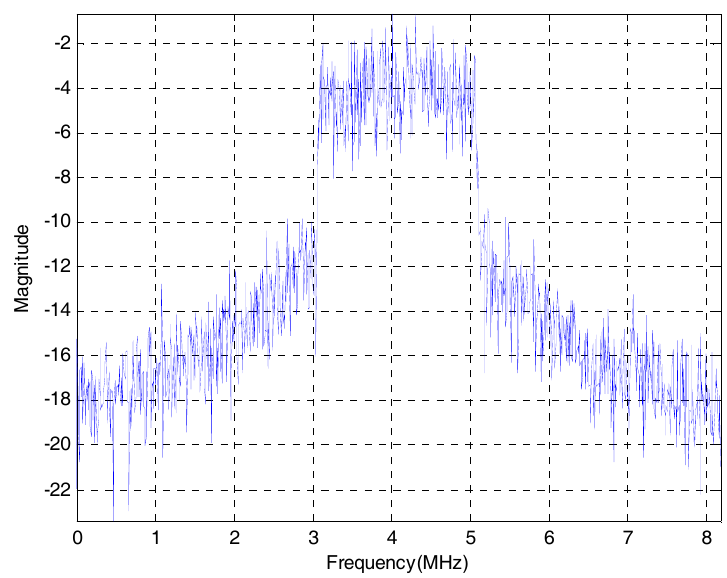
Sensors 2017 , 17 , 1568 Figure 8. Signal spectrum distribution of the BeiDou B1I IF signals. Figure 8. Signal spectrum distribution of the BeiDou B1I IF signals.